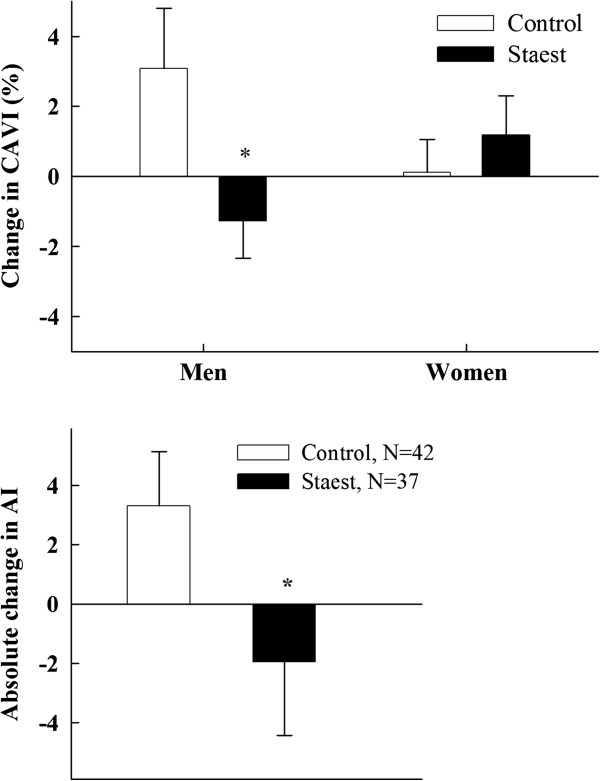
Upper panel: Percent change in cardio-ankle vascular index (CAVI) in men and women consuming control (n=45) and plant stanol ester (staest) (n=43) spread for six months. *p<0.05 from controls. lower panel: change in augmentation index (AI) in subjects consuming control and plant stanol ester (staest) spread for six months. *p<0.05 from controls.